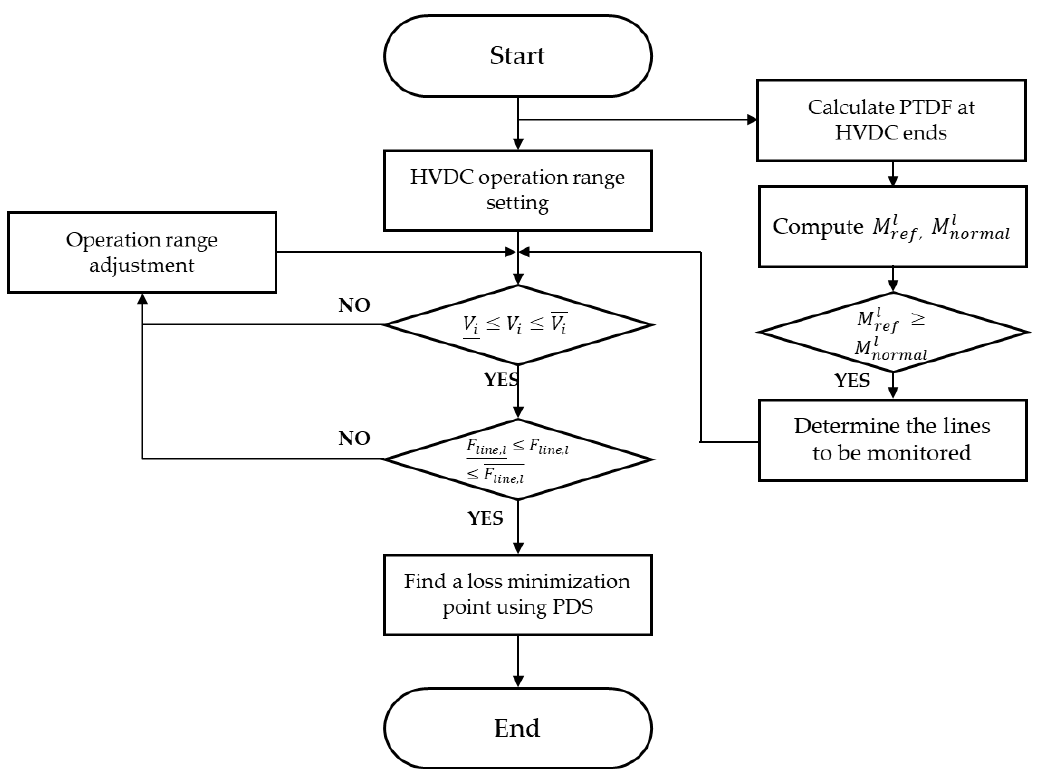
Figure 4. Algorithm of the system total loss minimization (STLM) control.